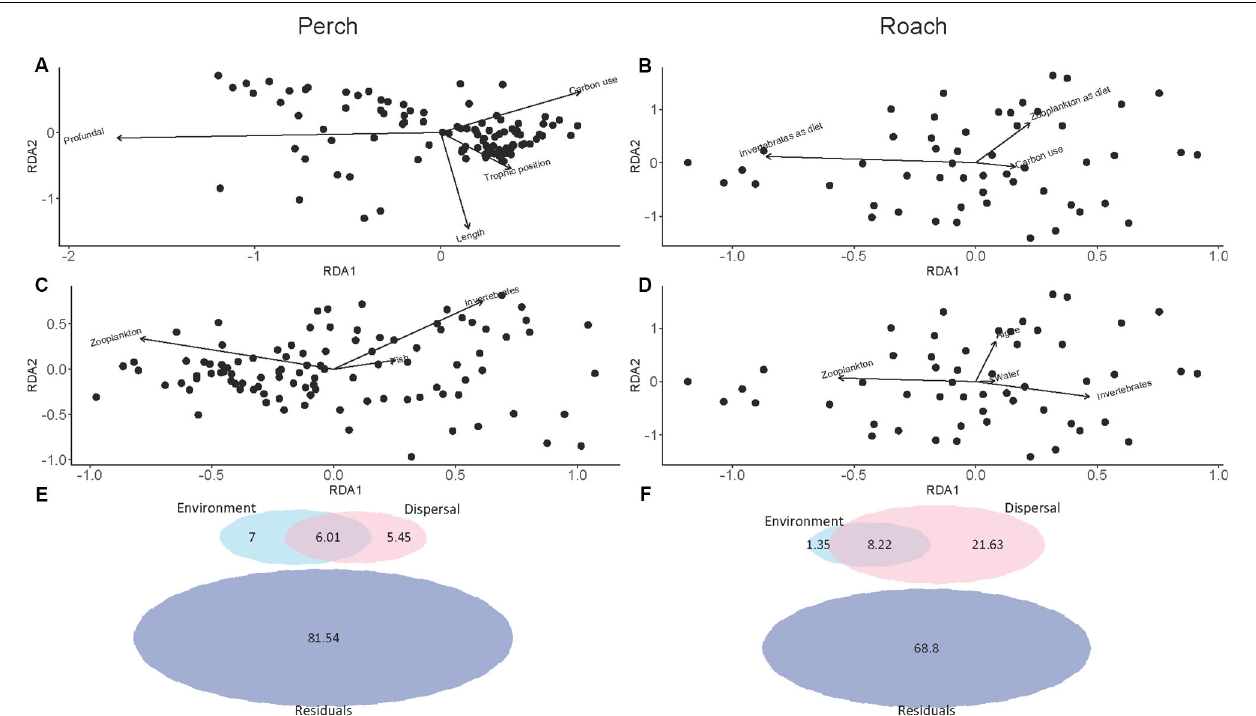
FIGURE 5 | pRDA plot showing the covariation between the composition of intestinal microbial communities and environmental factor in perch (A) and in roach (B) , shown as arrows. pRDA plot showing the covariation between the composition of intestinal microbial communities and dispersal factors in perch (C) and in roach (D) , shown as arrows. Proportion of variance in intestinal microbial communities explained by environmental and dispersal factors from variation partitioning analysis in perch (E) and in roach (F) . Residuals is variation in community composition unexplained by environment and dispersal factors.